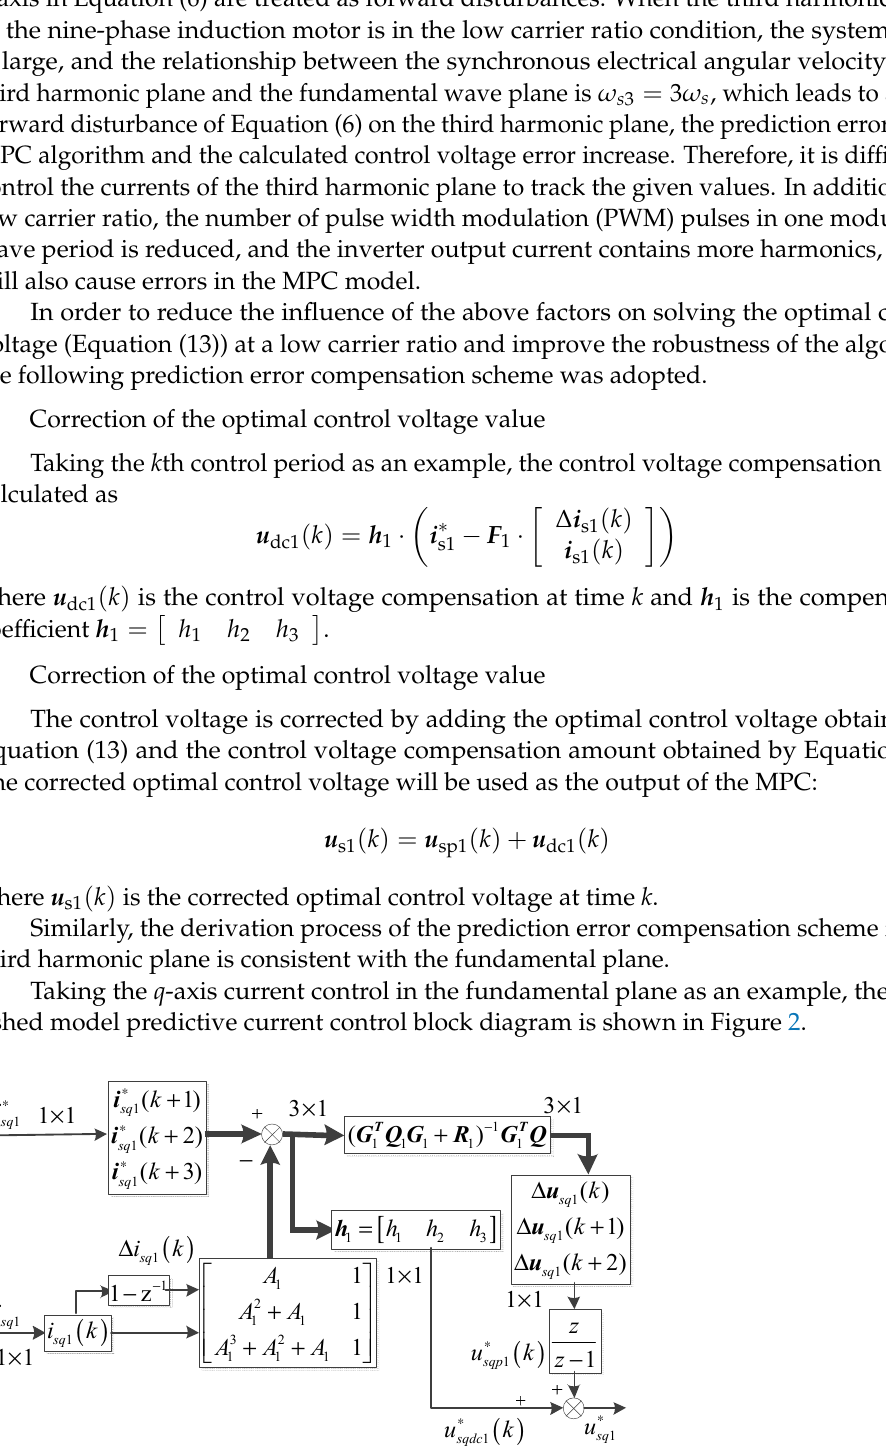
Figure 2. Model predictive control (MPC) principle with a prediction error compensation scheme.